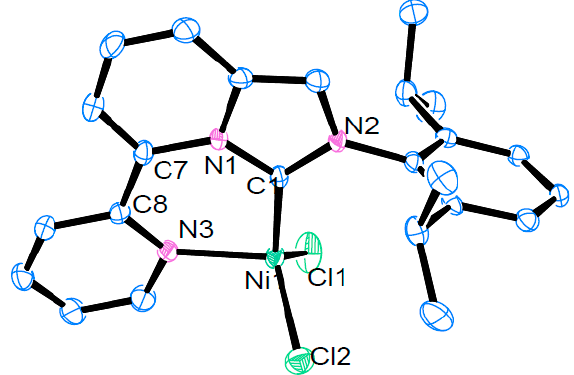
Figure 3. Molecular structure of 7 . Thermal ellipsoids are set at 50% probability. Hydrogen atoms have been omitted for clarity. Selected bond lengths [ Å ] and angles [°]: Ni(1)–C(1) 1.937(2), Ni(1)–N(3) 2.008(2), Ni(1)–Cl(1) 2.2077(8), Ni(1)–Cl(2) 2.2439(7); C(1)–Ni(1)–N(3) 92.84(9). Selected torsion angles [ ◦ ]: C(1)–N(1)–C(7)–C(8) -1.1(4), N(1)–C(7)–C(8)–N(3) -8.4(3), C(7)–C(8)–N(3)–Ni(1)